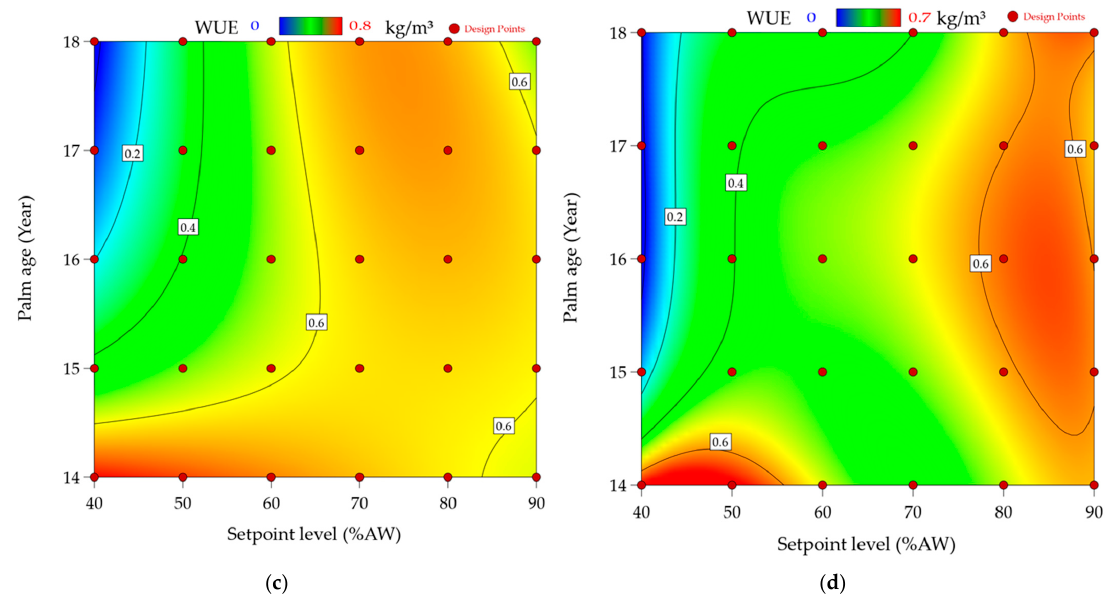
Figure 8. E ff ect of irrigation water levels at the di ff erent minimum setpoints (%AW) and palm ages (year) on water use e ffi ciency (WUE, kg/palm) under di ff erent micro irrigation systems, i.e., ( a ) subsurface irrigation system, ( b ) subsurface drip irrigation system, ( c ) drip irrigation system, and ( d ) bubbler irrigation system, of date palm cv. Khalas.